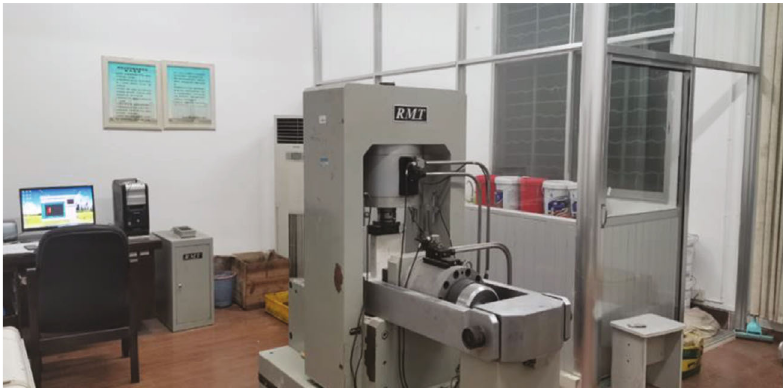
Figure 3: RMT-150 rock mechanics test